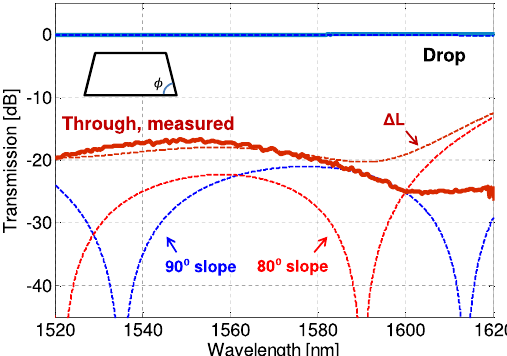
Figure 5. Measured normalised through and drop port powers of the fabricated balanced Mach-Zehnder interferometer. Dashed lines indicate simulations to compare the transmission characteristics of vertical 90° versus non-vertical sidewall slope of 80° and also with a small path length difference of Δ L . (inset) Trapezoidal waveguide with sidewall angle of φ .